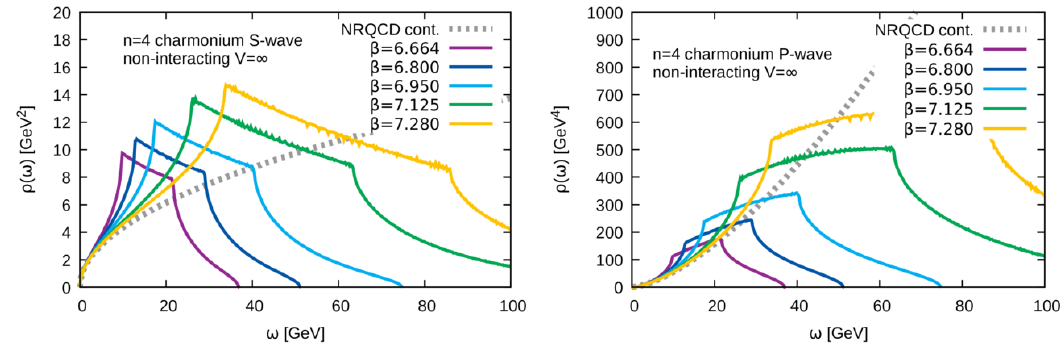
Figure 27 . A selection of lattice NRQCD charmonium spectral function in the absence of inter- actions in the thermodynamic limit at Lepage parameter n = 8. The S-wave channel is shown on the left, the P-wave channel on the